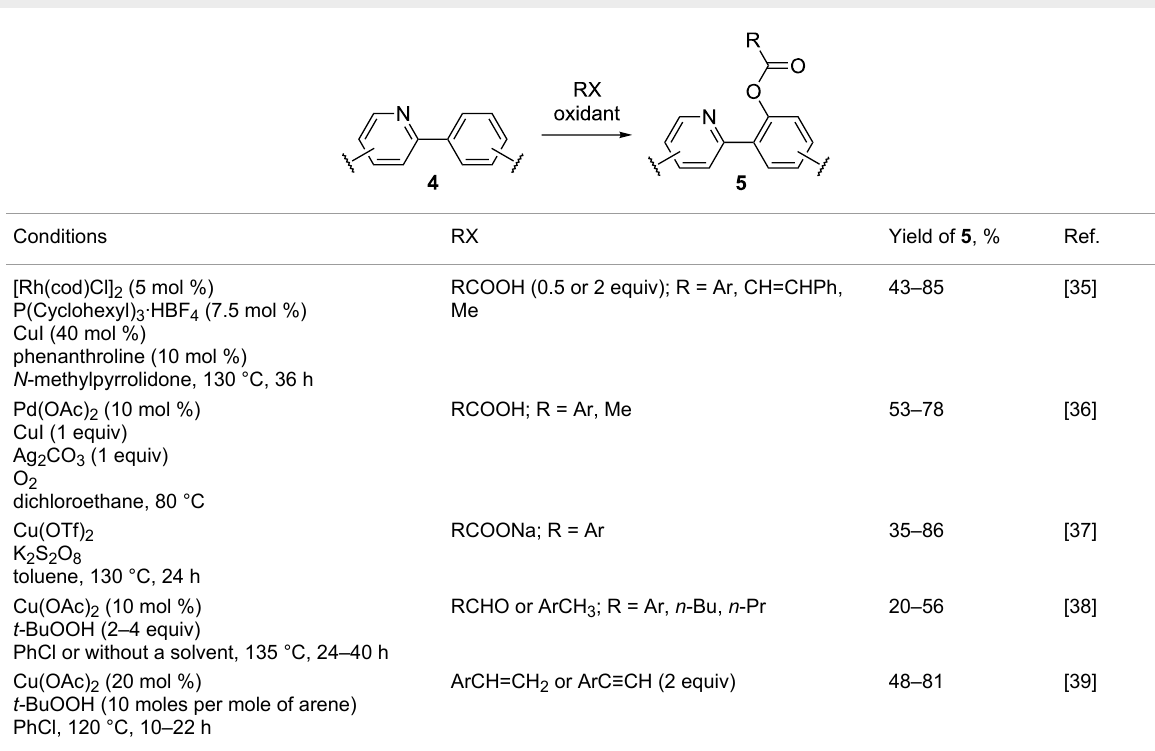
Table 1: ortho -Acyloxylation of arenes 4 directed by pyridine